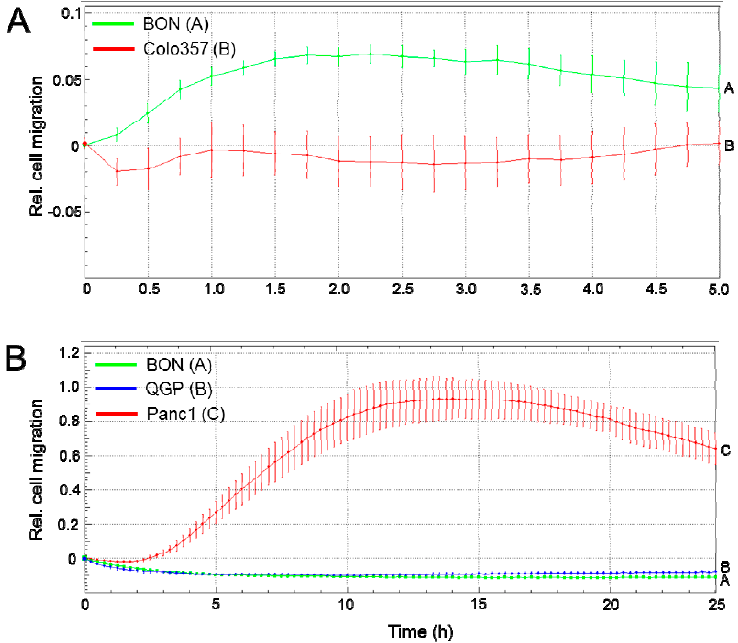
Figure 5. Cell migration assays of BON and QGP cells. ( A ) Assay in a chemokinesis setup with non-motile Colo357 cells as negative control. ( B ) Assay in a chemotaxis setup with Panc1 cells as positive control. Data represent the mean ± SD from four wells per condition. The assays shown are representative of three independent assays with very similar results.